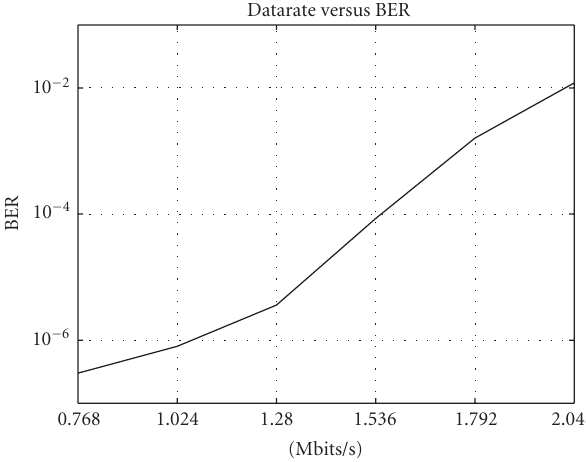
Figure 3: BER measurement of ML2724SK-02